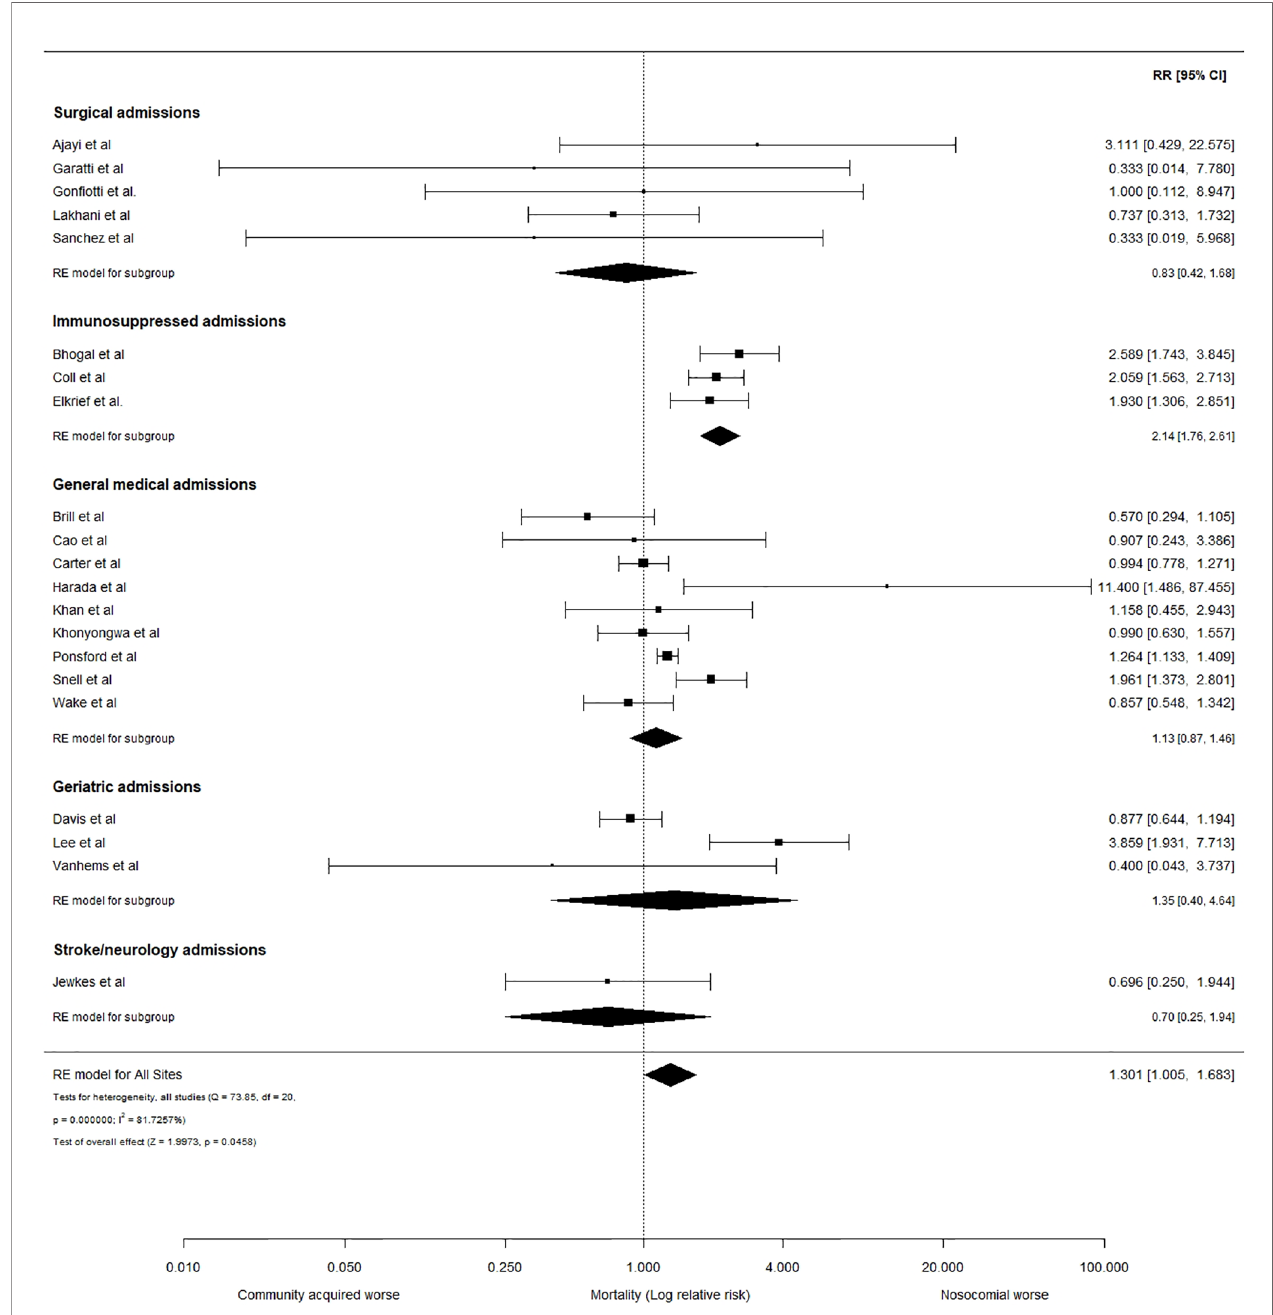
FIGURE 3 | Relative risk of mortality in hospitalized adults with nosocomial and community-acquired COVID-19. Forest plot assessing the relative risk (RR) and 95% con fi dence interval (95% CI) of mortality in adults hospitalized with community-acquired and probable nosocomial COVID-19, according to the study de fi nitions. The size of each box is proportional to the size of the individual hospital site (A-N), with the error bars representing the 95% CIs. The diamond represents the pooled average across studies, based on a random effects (RE) model. I 2 : heterogeneity variance, calculated using restricted effects maximum likelihood